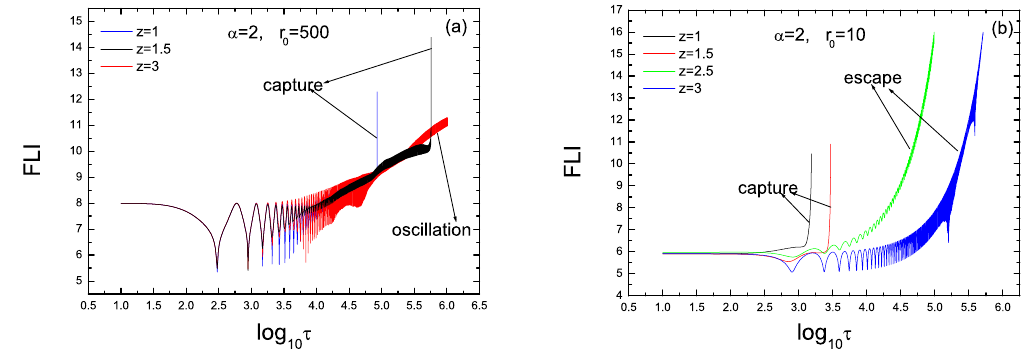
Figure 10 . FLIs for r 0 = 500 and r 0 = 10 with di(cid:11)erent z . Here, (cid:11) = 2, T =